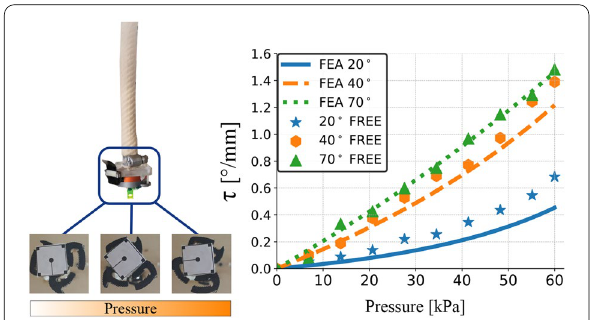
Fig. 7 The finite element model validation. Experimental setup used to measure the rotation of FREE (left). Rotation per unit length of 20 ◦ , 40 ◦ , and 70 ◦ FREEs, all 130 mm in length, 9.52 mm inside diameter, and 0.8 mm wall thickness (right). The curves are the results with the finite element model and dots are experimentally measured